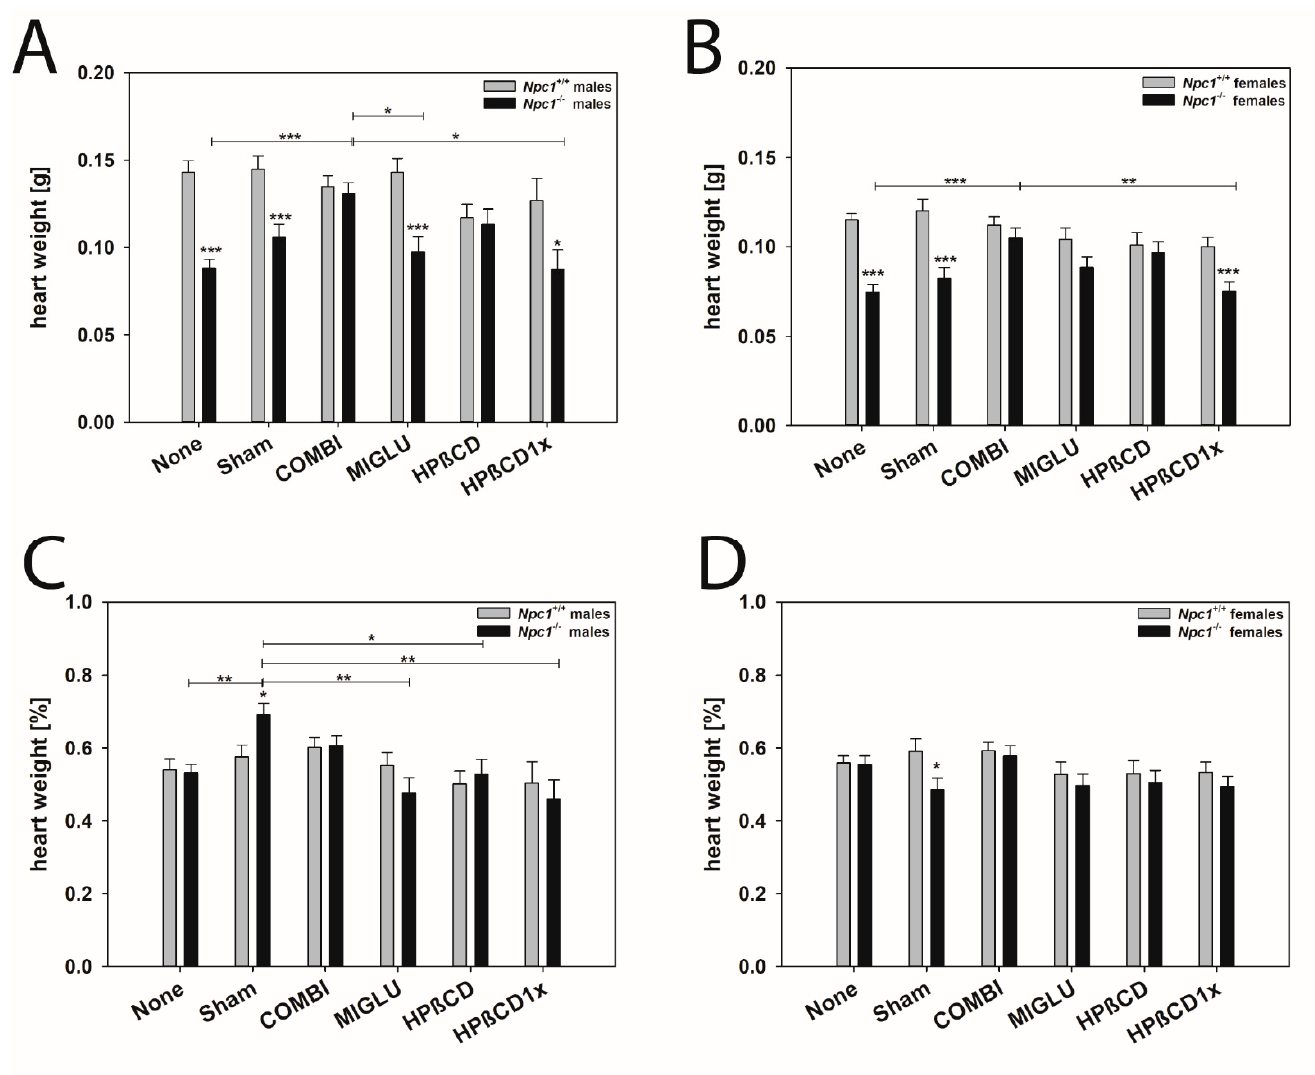
Figure 2. Heart weight ( A , B ) and relative heart weight ( C , D ) of Npc1 mice. Male ( A , C ) and female ( B , D ) mice. Significant post-hoc tests are indicated by asterisks (* p < 0.05, ** p < 0.01, *** p < 0.001). Data are means ± SEM.